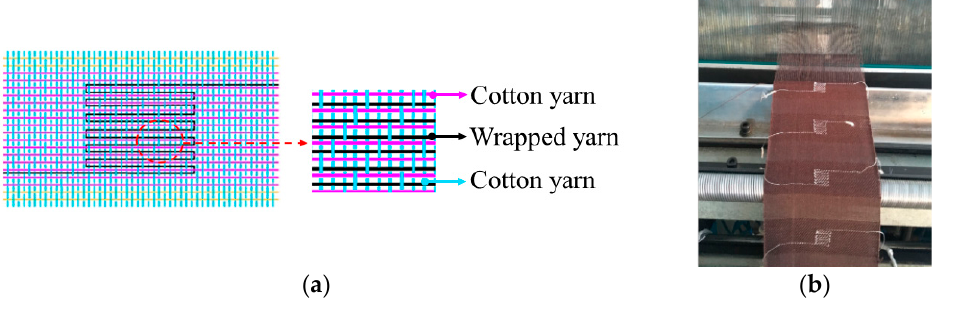
Figure 3. Fabrication of fabric temperature sensors. ( a ) Structure of the fabric sensors; ( b ) Fabrication process.